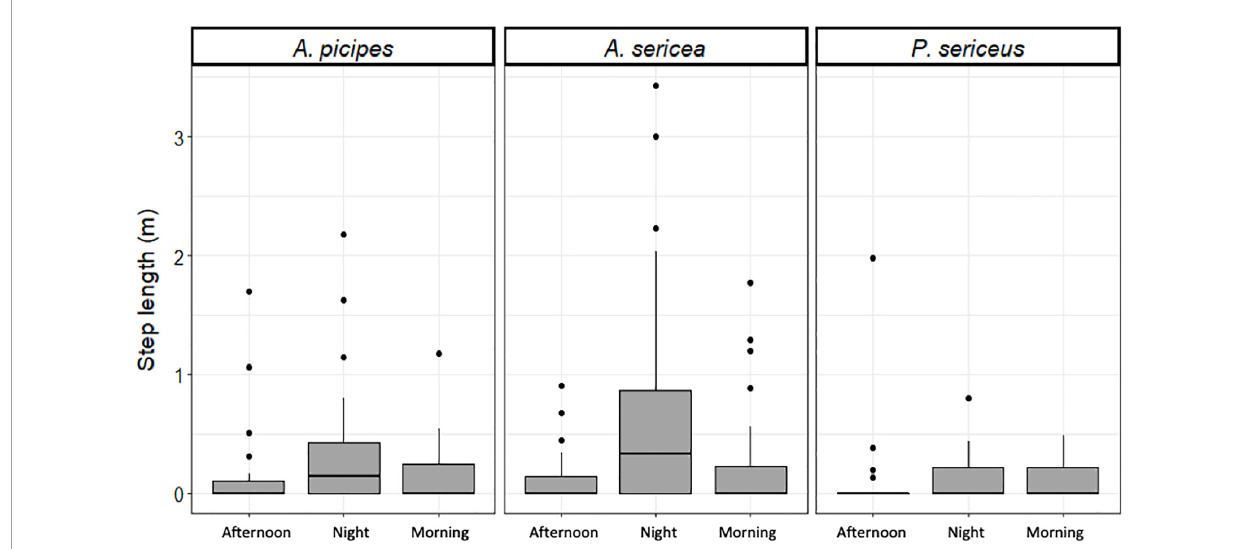
FIGURE5 Step length per time of day for the three study species in the field.